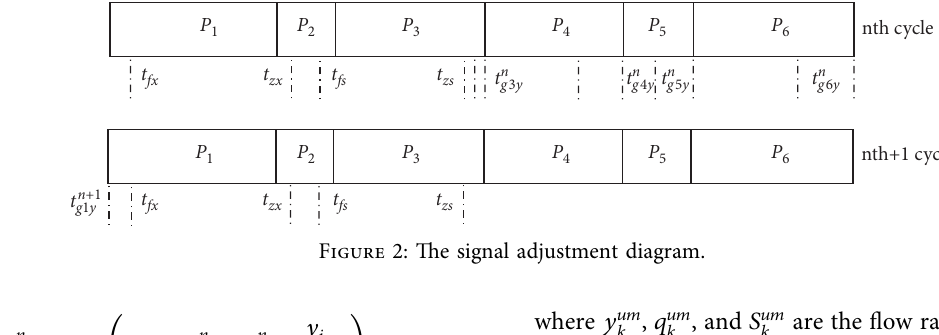
Figure 2: The signal adjustment